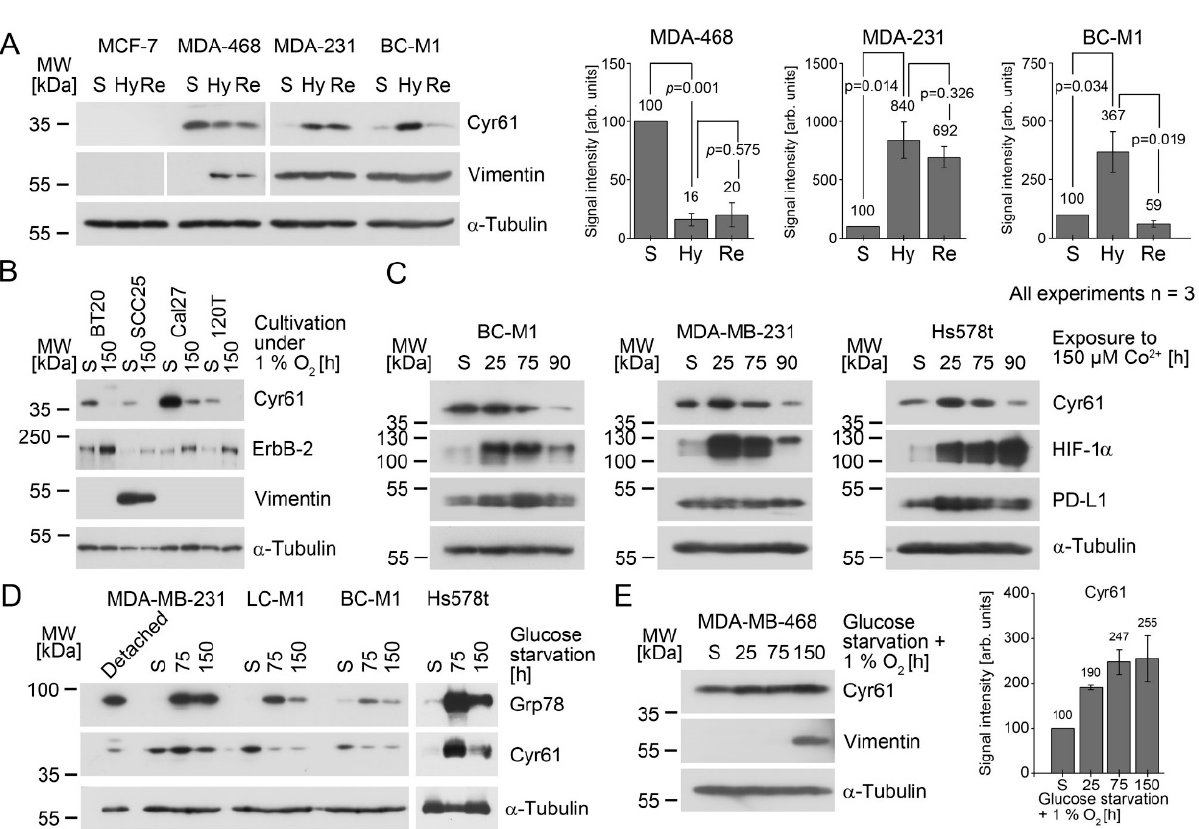
Figure 2. Response of the Cyr61 levels to hostile microenvironmental conditions; analyses by Western blot analysis. The starting conditions for all of the experiments were the standard cell culture conditions (S). ( A ) Response of Cyr61 levels to chronic hypoxia (14 days 1% O 2 ; condition Hy) and reoxygenation (Re: Hy followed by 10% O 2 for 4 h). The statistical analyses of the changes in the protein levels are shown in the bar diagrams (right), and the obtained p -values are presented as numbers. The p -values were calculated using Student’s t -test (n biol = 3). The corresponding scatterplot is shown in Figure S2. ( B ) Downregulation of Cyr61 under hypoxia (1% O 2 ) and the induction of ErbB-2 under hypoxia. ( C ) Effect of the stabilization of HIF-1 α to Cyr61 and PD-L1 levels after the treatment of the cells with cobalt chloride. ( D ) Effect of glucose starvation on the Cyr61 levels. As a large amount of MDA-MB-231 cells detached from the cell culture flask after 50 h of glucose withdrawal, the detached cells were analysed separately. The 78 kDa glucose-regulated protein (Grp78) was analysed as a positive control for a cellular response after glucose withdrawal. ( E ) Induction of Cyr61 under hypoxia and glucose starvation. The diagrams display the quantitative analyses of the Cyr61 levels of the Western blot images (n biol = 3). The numbers above the error bars (standard deviation) represent the average values. The corresponding scatterplot is shown in Figure S3.